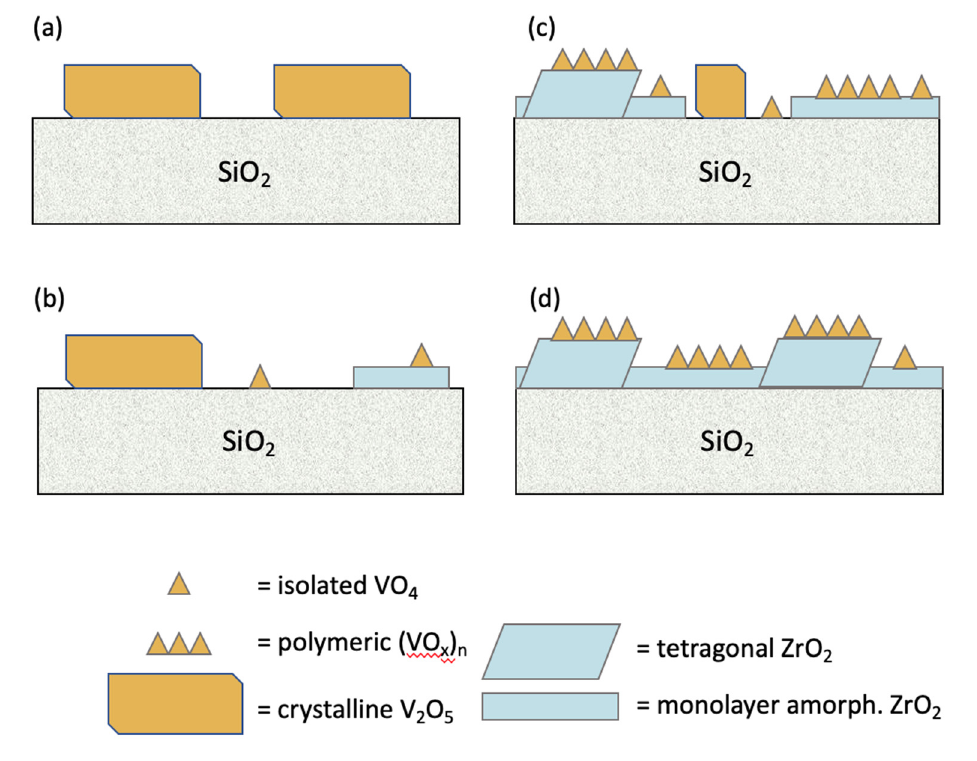
Figure 5. Proposed zirconia and vanadia structures. ( a ) 5VOx / S, ( b ) VOx / 5ZrOx / S, ( c ) VOx / 10ZrOx / S, and ( d ) VOx / 20ZrOx / S.